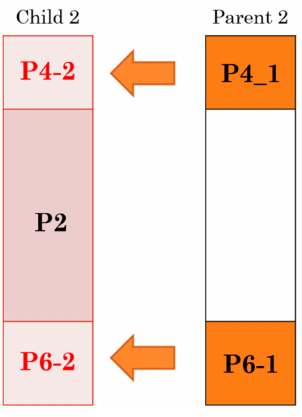
Figure 8. Generating child